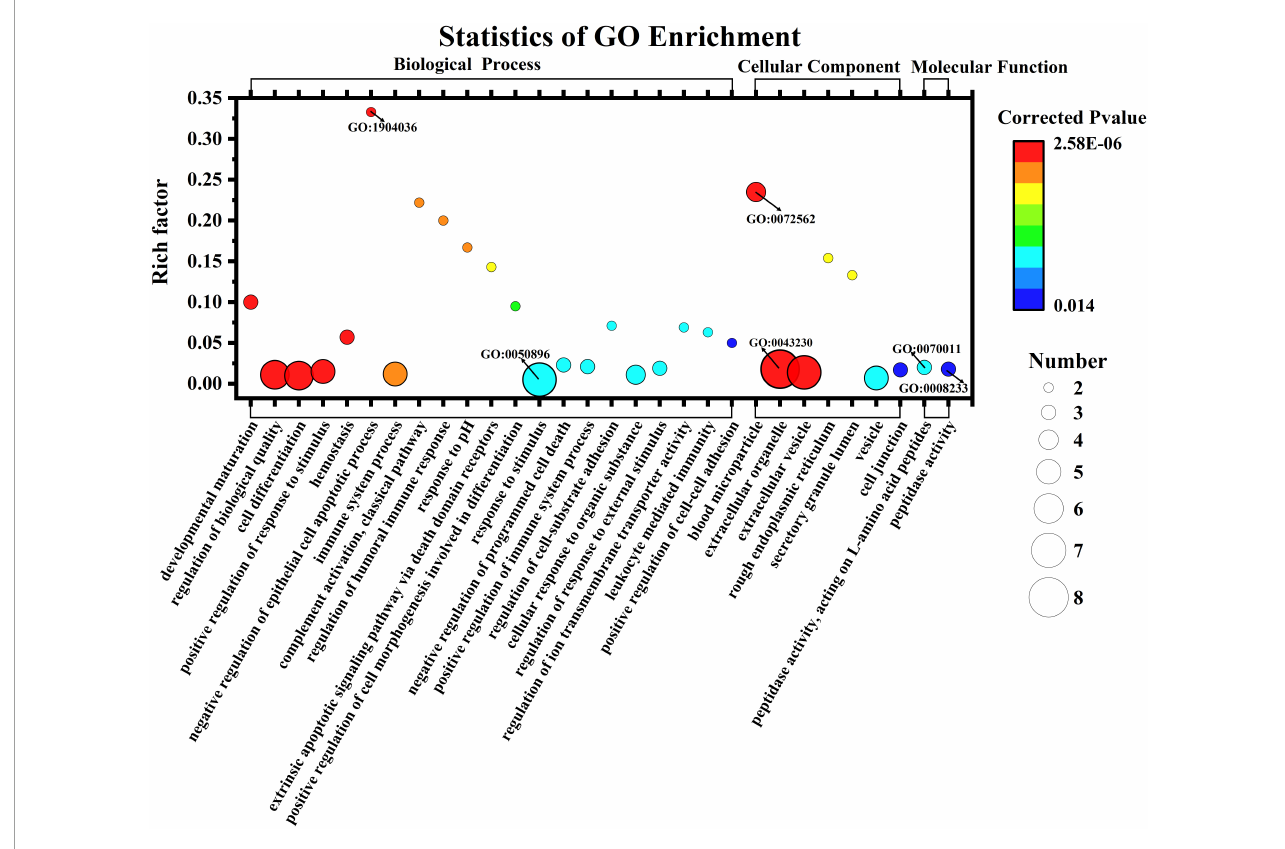
FIGURE6 Gene Ontology enrichment classification of differentially expressed casein from Korean and Han ethnic groups in China.